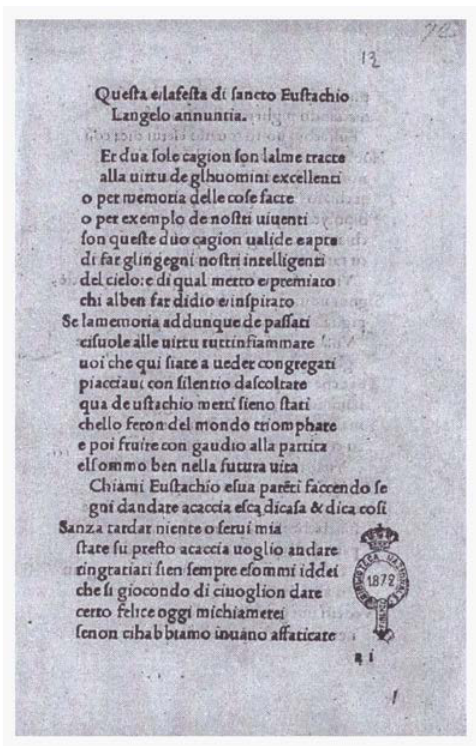
Figure 1 – Rappresentazione di Sant’Eustachio , [s.n.t., but Florence, Miscomini, before 1492], f. a1r (BNCF, P.6.36). By permission of Ministero per i beni e le attività culturali / Biblioteca Nazionale Centrale. Firenze